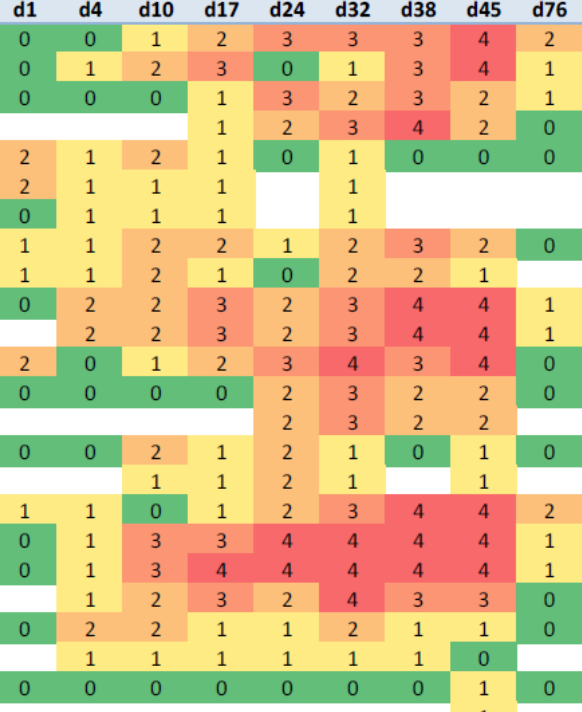
Figure 3. Example of the course of electronic patient reported outcome measures in a 75-year-old patient who underwent definitive radiochemotherapy for locally advanced head and neck cancer. Day 45 constitutes the last assessment during therapy; d76 was approximately 3 weeks after the end of treatment. d: day; ADL: activities of daily